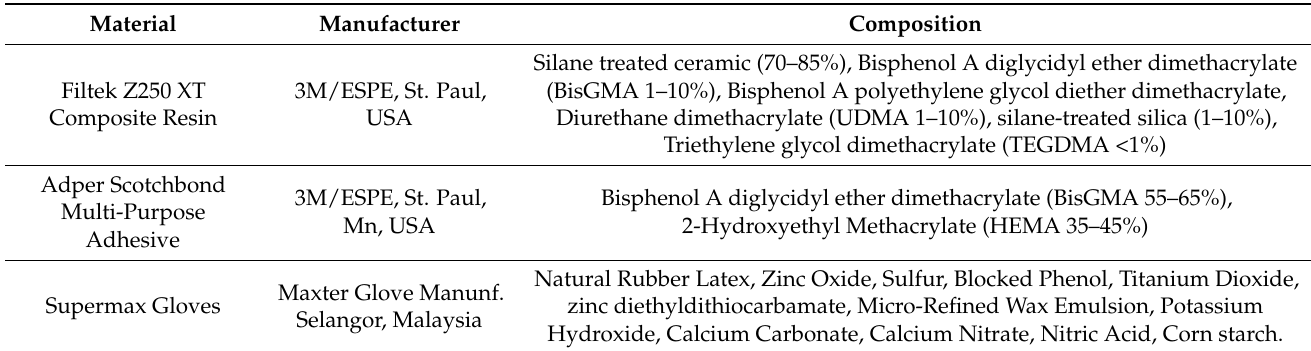
Table 1. Complete information on the composition of gloves, adhesive, and composite resin used in this study